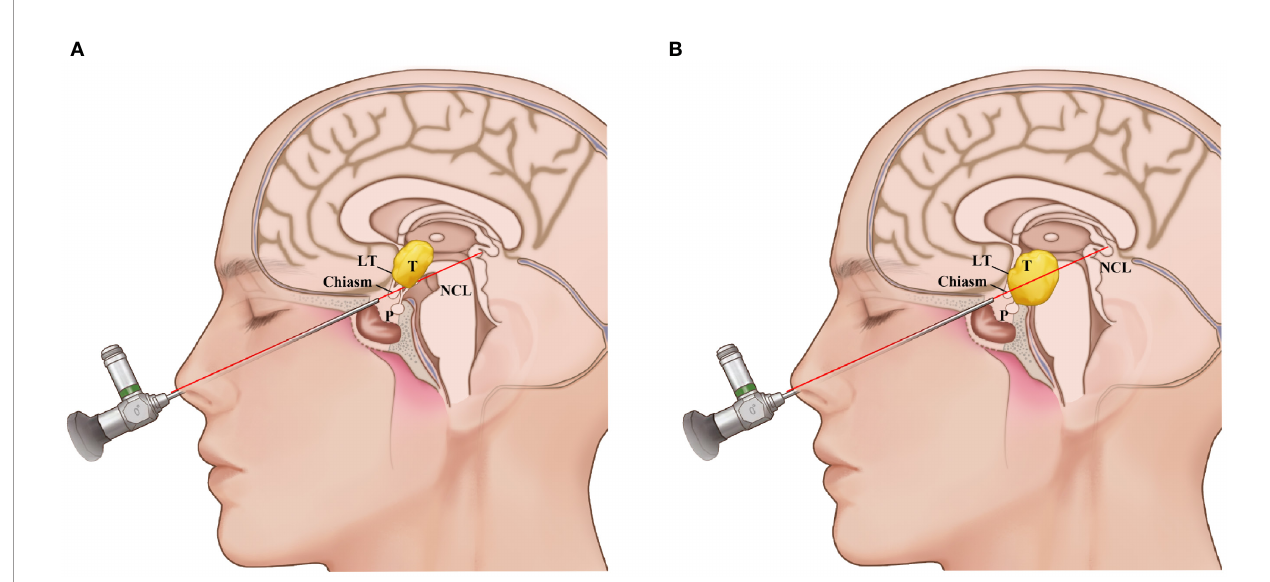
FIGURE 1 | Schematic representation of the use of the nasal-chiasmic line for corridor selection in third ventricle lesion. (A) , If the percent of the supra-NCL region included over 20% of the tumor, then the lamina terminalis corridor was used to remove this part of the tumor. (B) If the area of the tumor in the infra-NCL region was over 10% and the area of the tumor in the infra-NCL region was over 20%, both lamina terminalis corridor and infrachiasmic corridor were used. NCL, nasal- chiasmic line; T, tumor; P, pituitary; LT, laminal